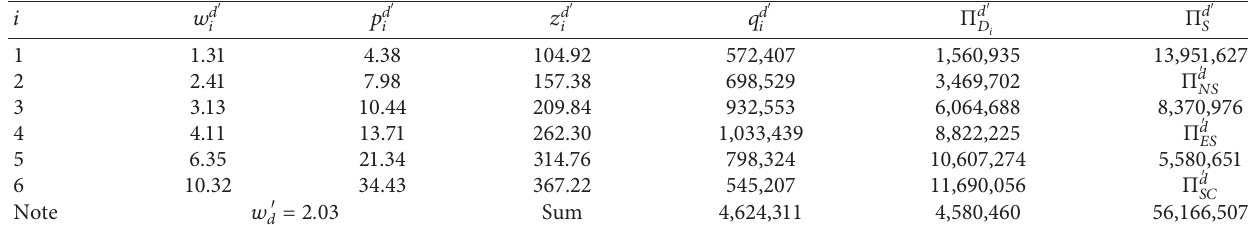
Table 8: Numerical analysis results of decentralized decision scenario without WGD